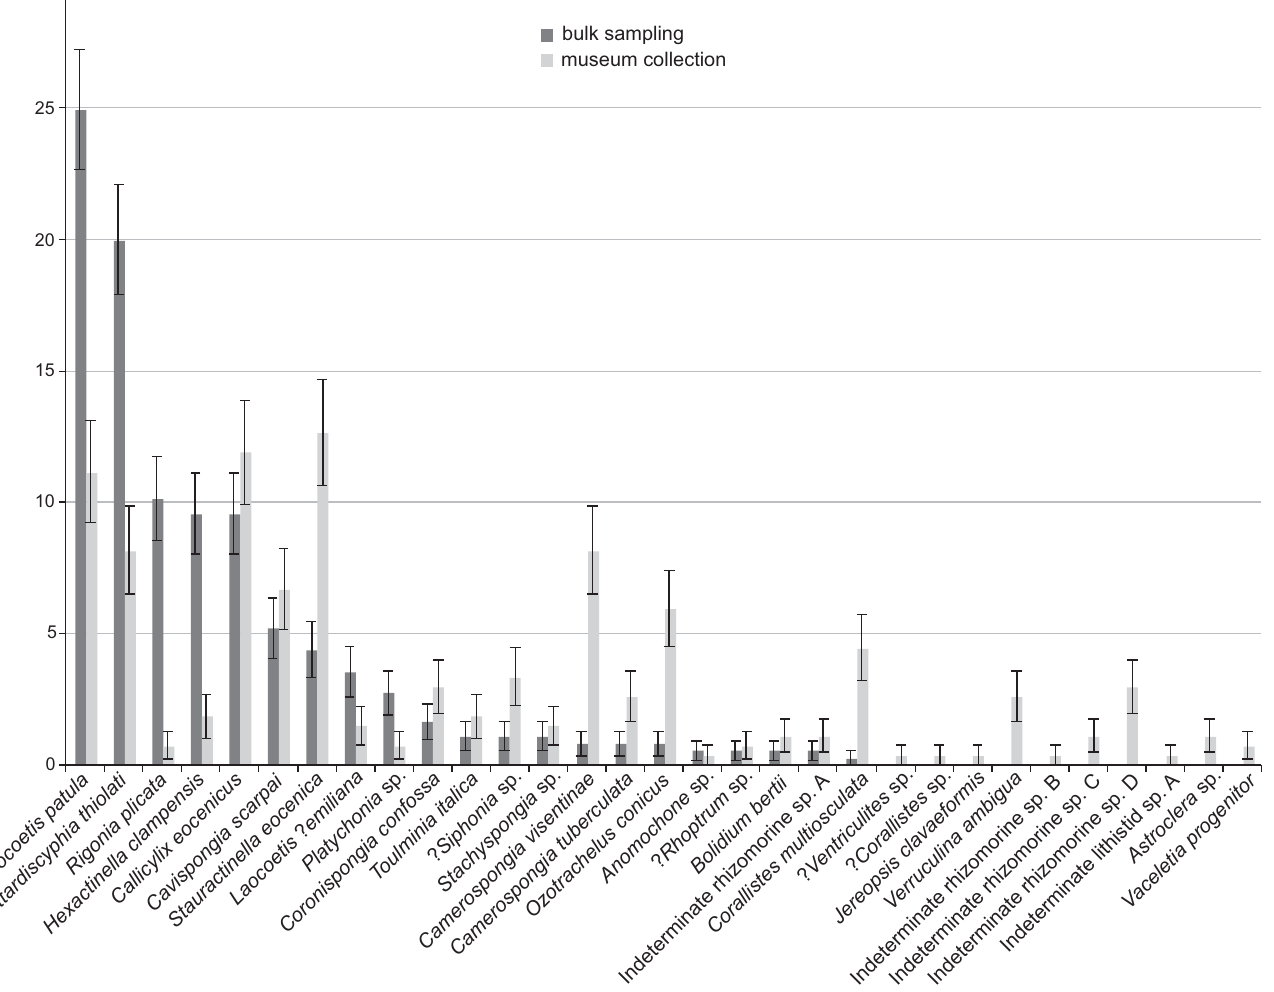
Fig. 9. Comparison between species frequency of museum collections (data from Frisone et al. 2016) and bulk sampling (this study). Error bars denote binomial standard errors of